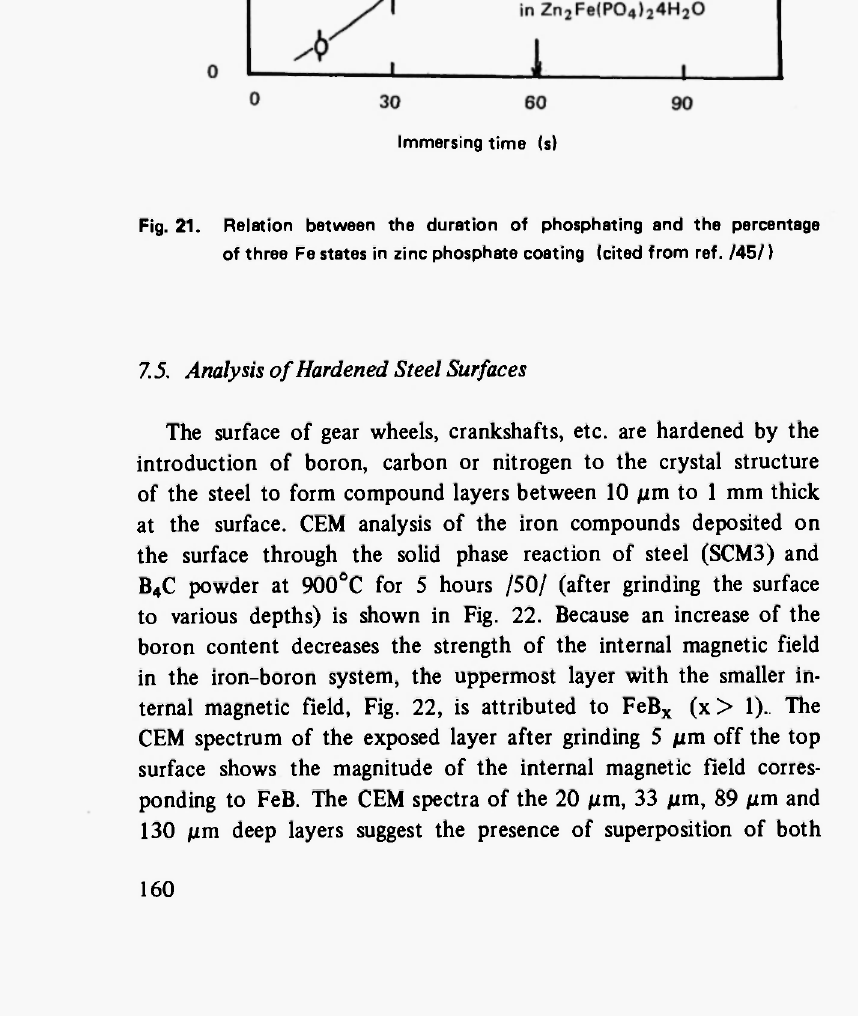
Fig. 21. Relation between the duration of phosphating and the percentage of three Fe states in zinc phosphate coating (cited from ref.